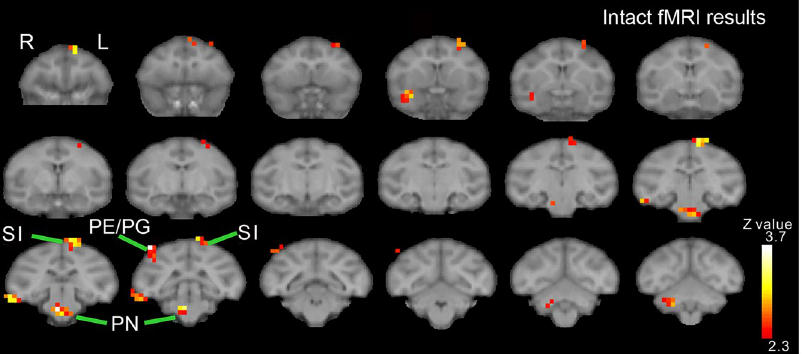
Figure 2. Brain activity in intact macaques. In untreated (“intact”) macaques, increased brain activity associated with a cold (10 °C) stimulus was observed in several brain areas including the parietal (PE/PG) and primary somatosensory cortices (SI) and pontine nuclei (PN).